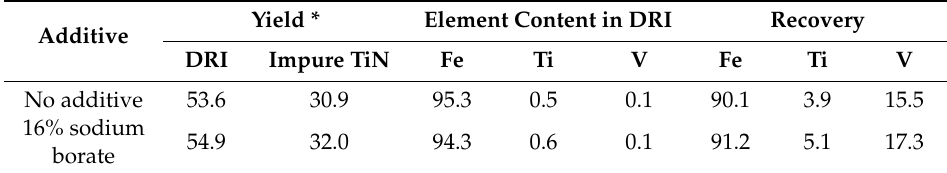
Table 4. Production index of magnetic separation (mass %).